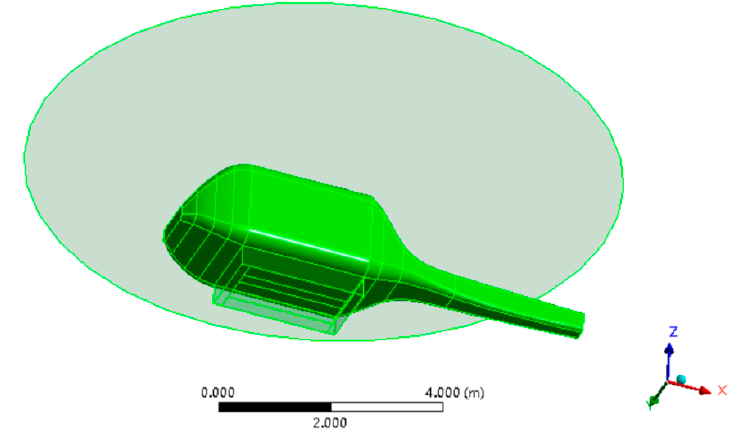
Figure 2. Helicopter and tank model in the simulation.